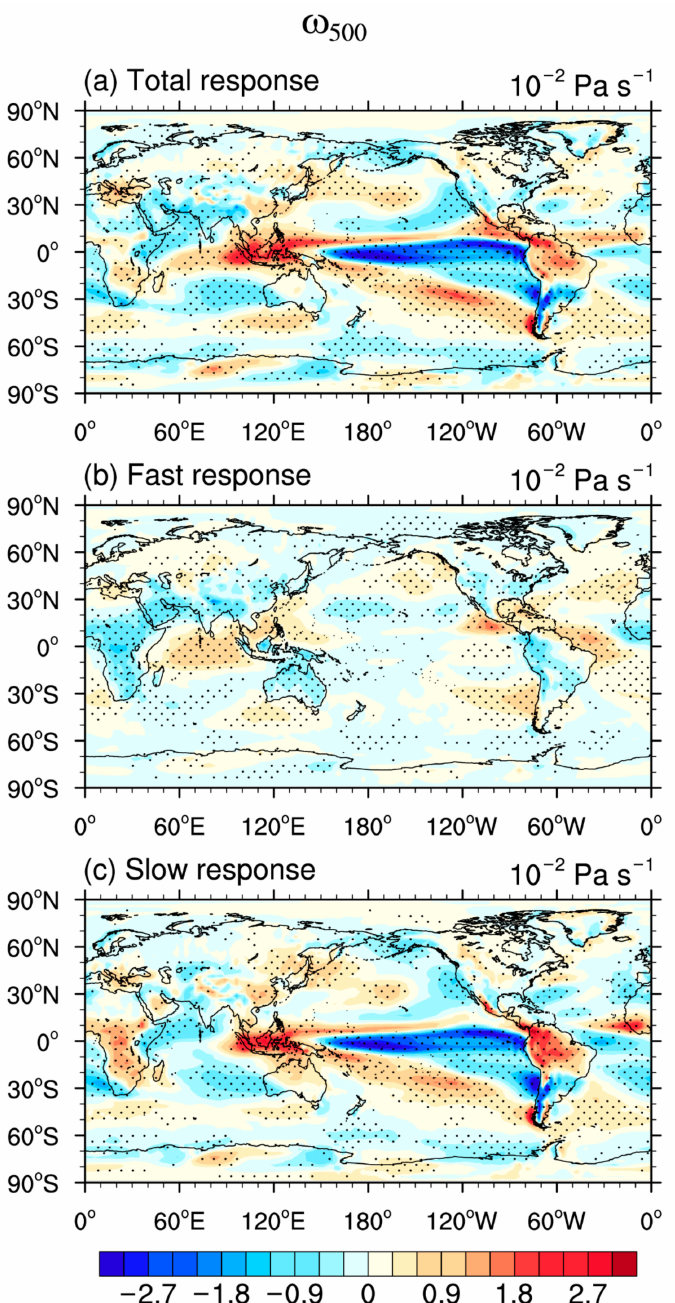
Figure 7. ( a ) Total, ( b ) fast, and ( c ) slow responses of global vertical velocity at 500 hPa ( ω 500 , units: 10 − 2 Pa s − 1 ). Black dot represents that at least 8 models agree with the sign of